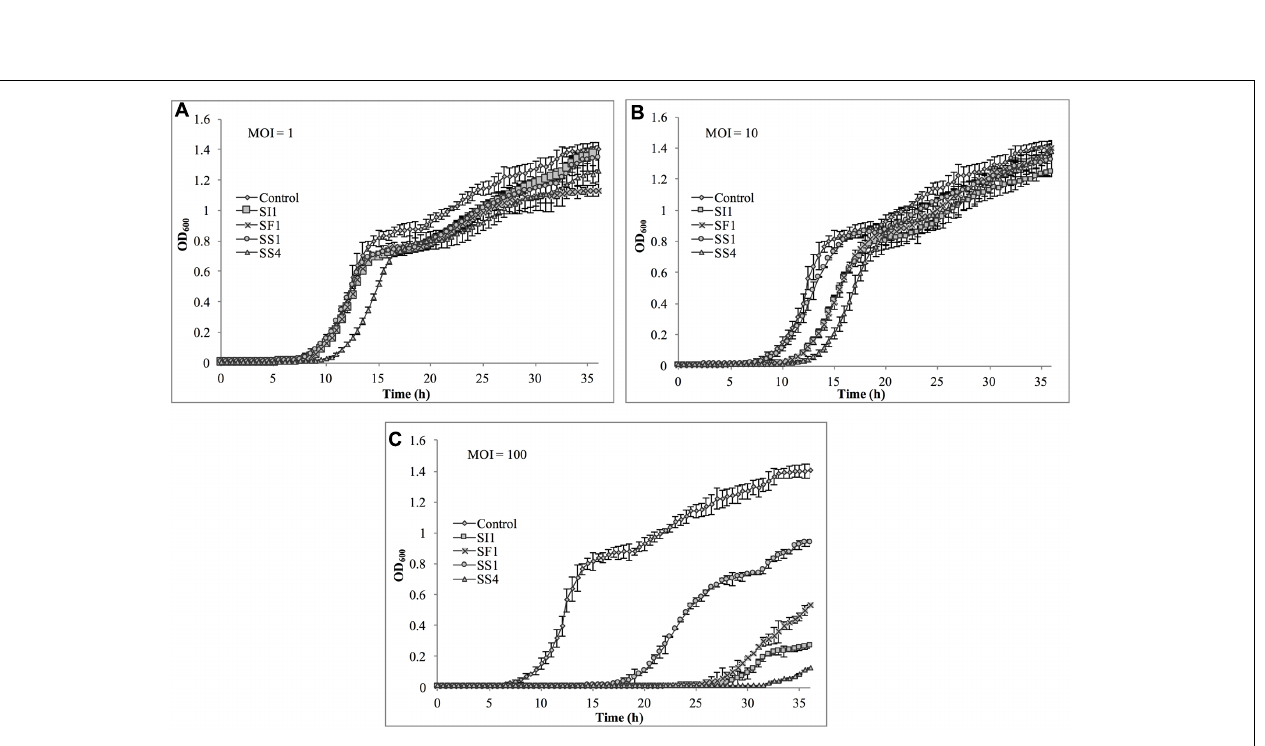
Frontiers in Microbiology |